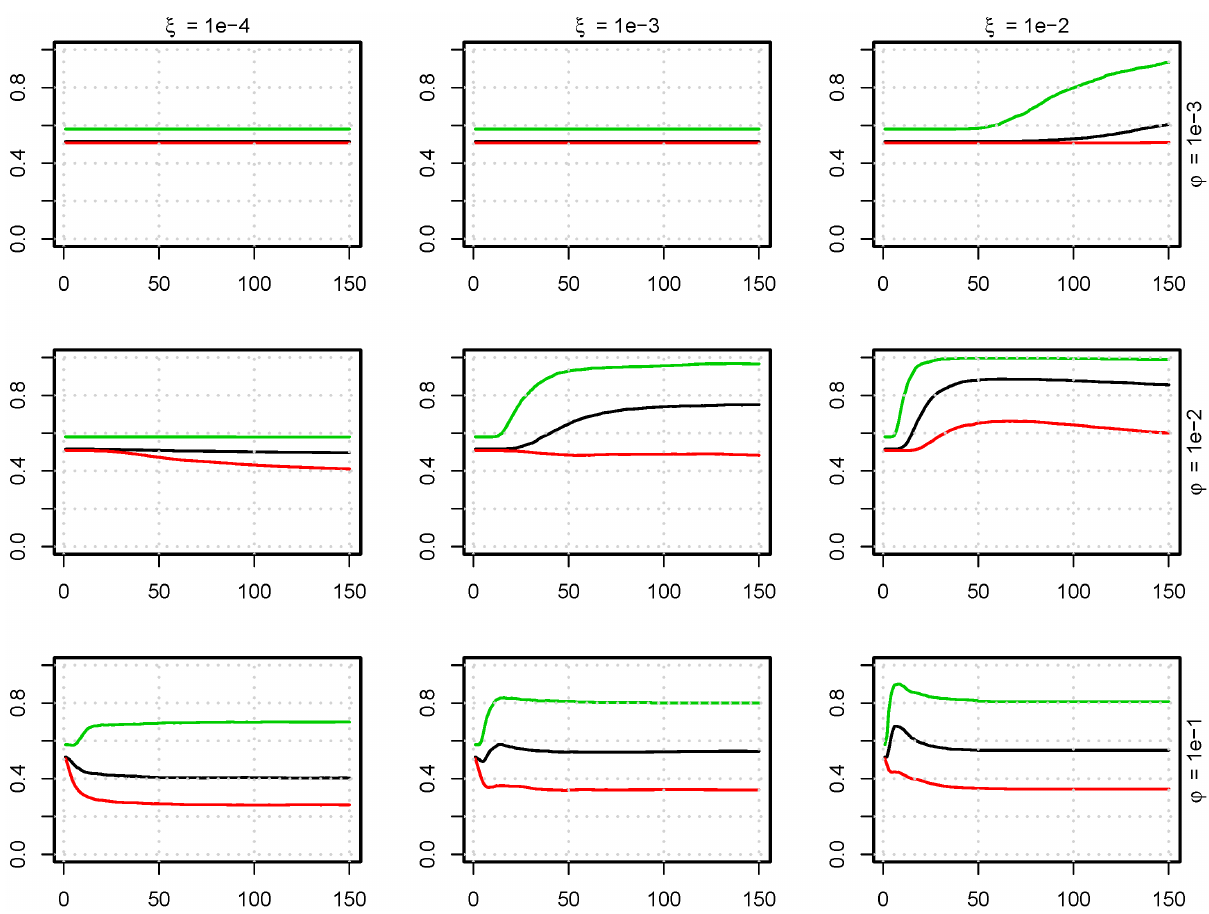
Figure 4. Level of homogenization of bacterial strains in a pig pen. The mean fraction of strains (y-axes) that is present in a pig ( P I ( S i , j w 0 : 01 : C ) / n S n p n pp ) as a function of time [days] (x-axes), with no antimicrobial treatment. The colors indicate the number of strains in the model: green =5 strains, black =10 strains, and red =20 strains. This is modelled for nine parameter sets of Q (excretion rate) and j (uptake fraction from the environment). ( n pp ~ 15 , n p ~ 1 , n R ~ 30 ).